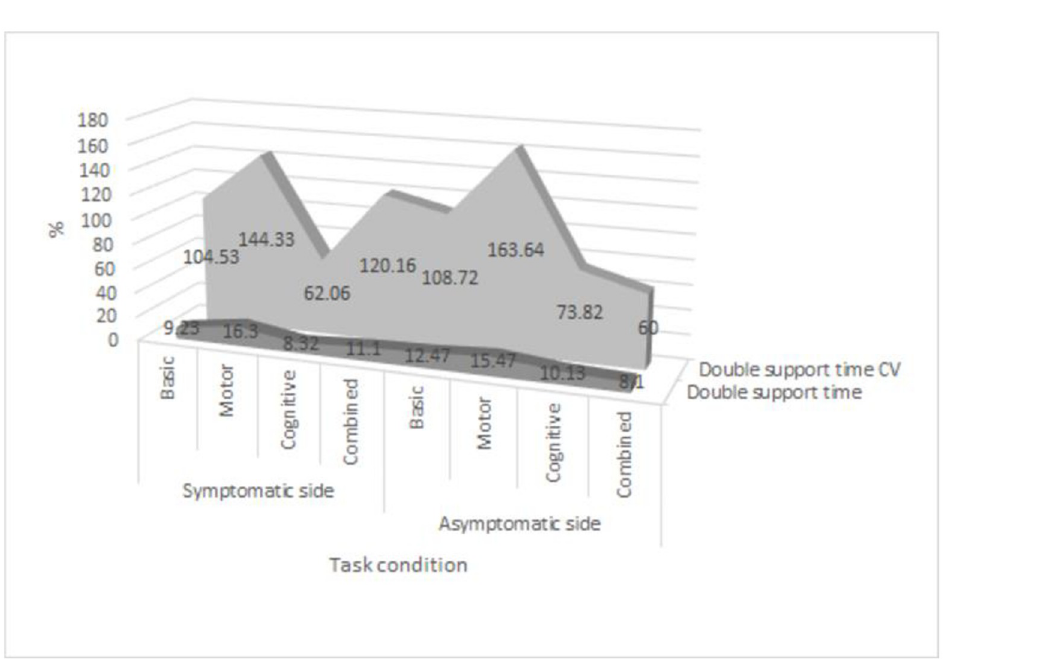
Fig 1. Swing time and double support time and their respective coefficient of variations. A. Change of swing time (%) and the respective coefficient of variation over 1 year. B. Change of double support time (%) and the respective coefficient of variation over 1